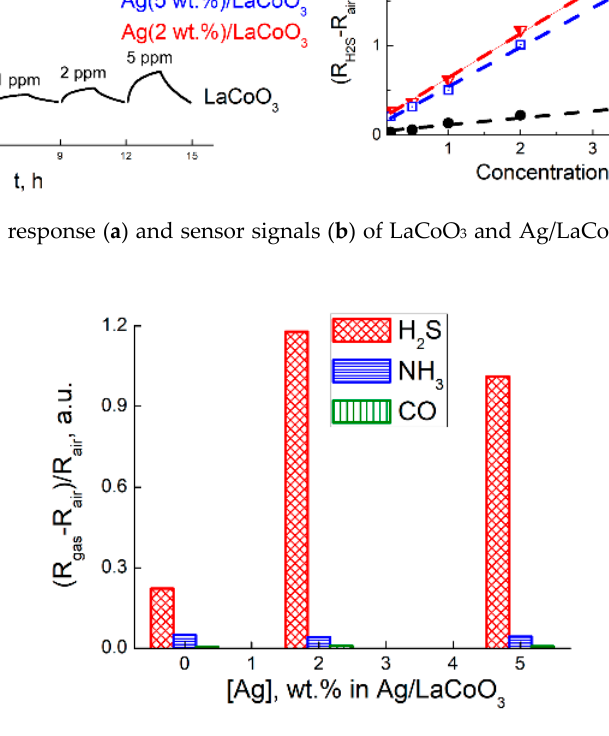
Figure 3. Comparison of sensor signals of LaCoO 3 and Ag/LaCoO 3 to 20 ppm CO, 20 ppm NH 3 and 2 ppm H 2 S at 200